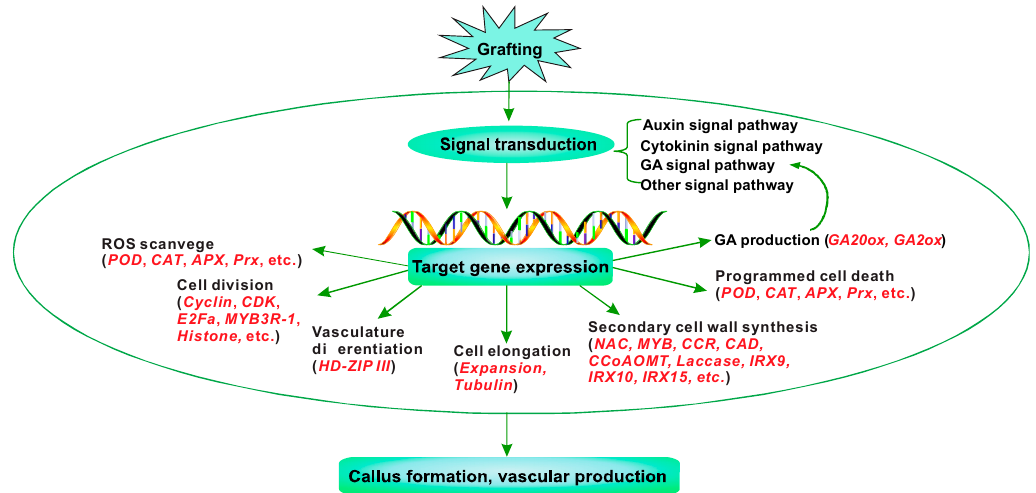
Figure 10. A putative molecular model of successful grafting in pecan.